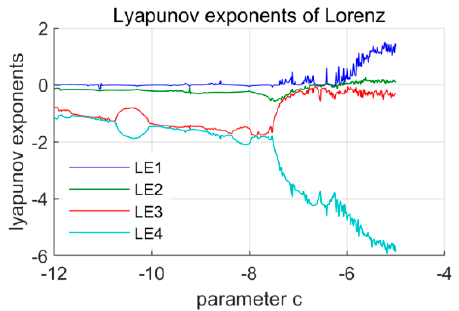
Figure 4. Lyapunov exponent spectra of system(2) vs. parameter c.